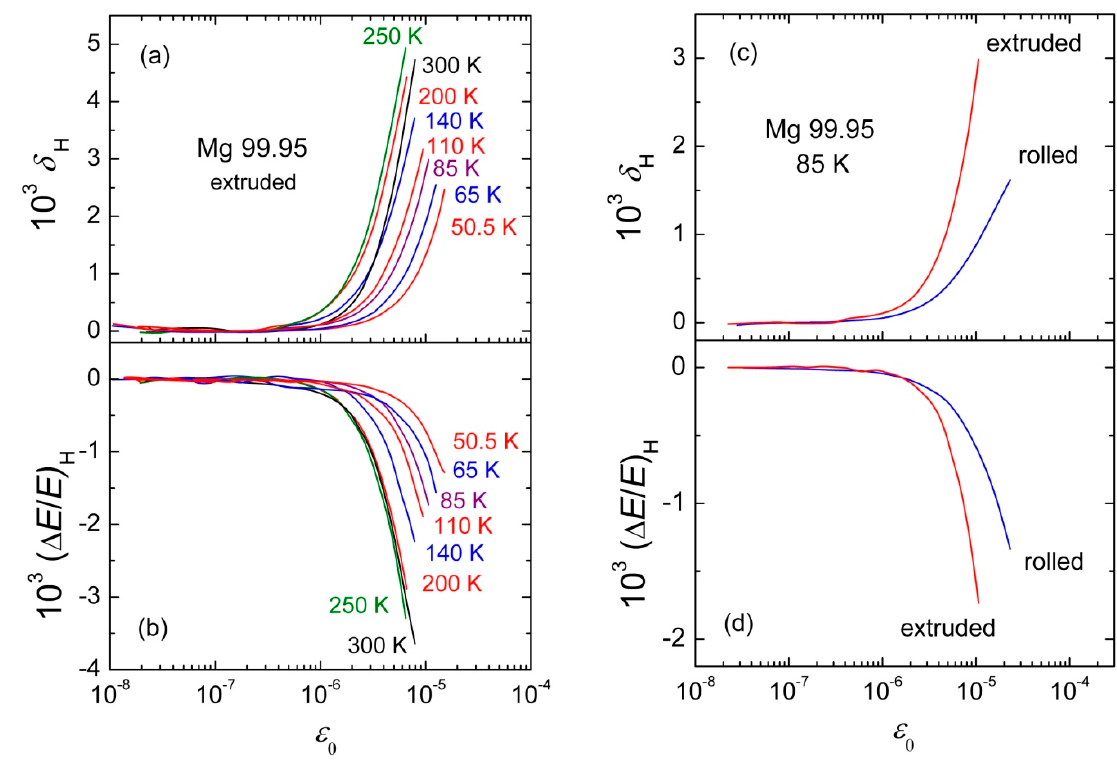
Figure 6. Effect of the temperature ( a , b ) and deformation mode ( c , d ) on the amplitude-dependent part of the decrement δ H and the modulus defect ( Δ E/E ) H in the extruded and rolled samples.